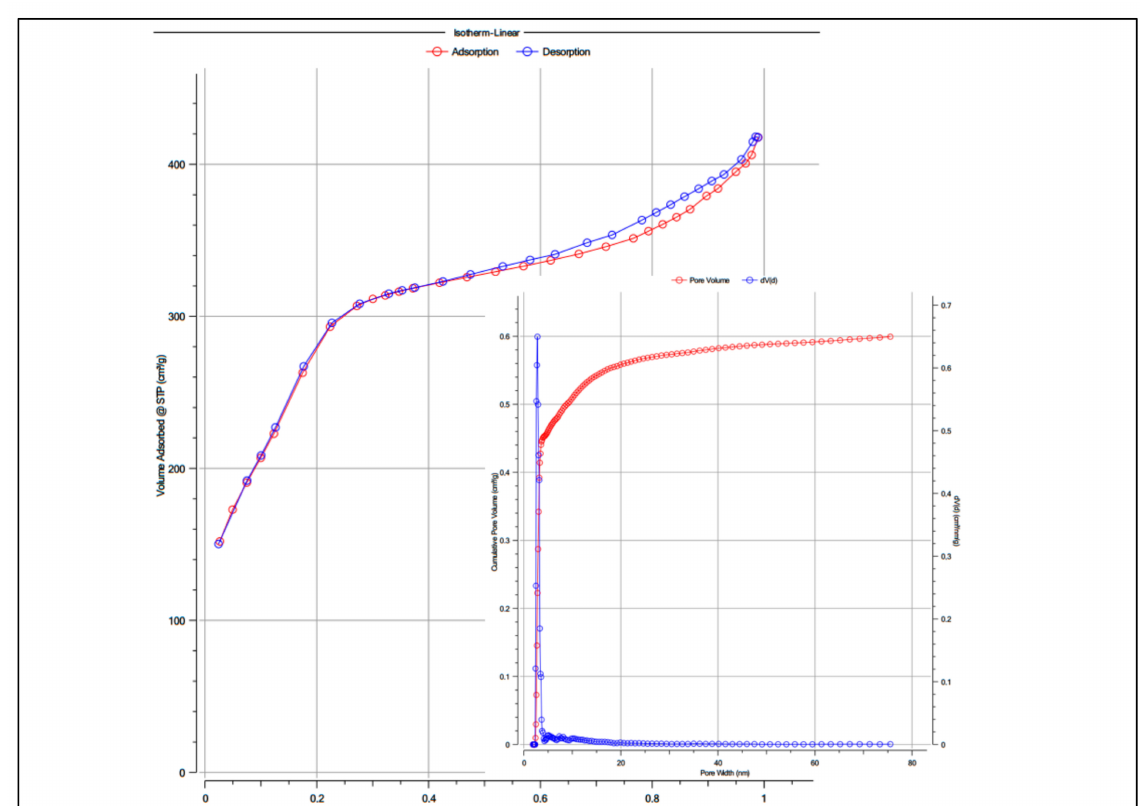
Figure 4. N 2 adsorption/desorption isotherm and pore size distribution for MCM-41. 29 Si –NMR MAS analysis of the MCM-41 and MCM-41/APS materials